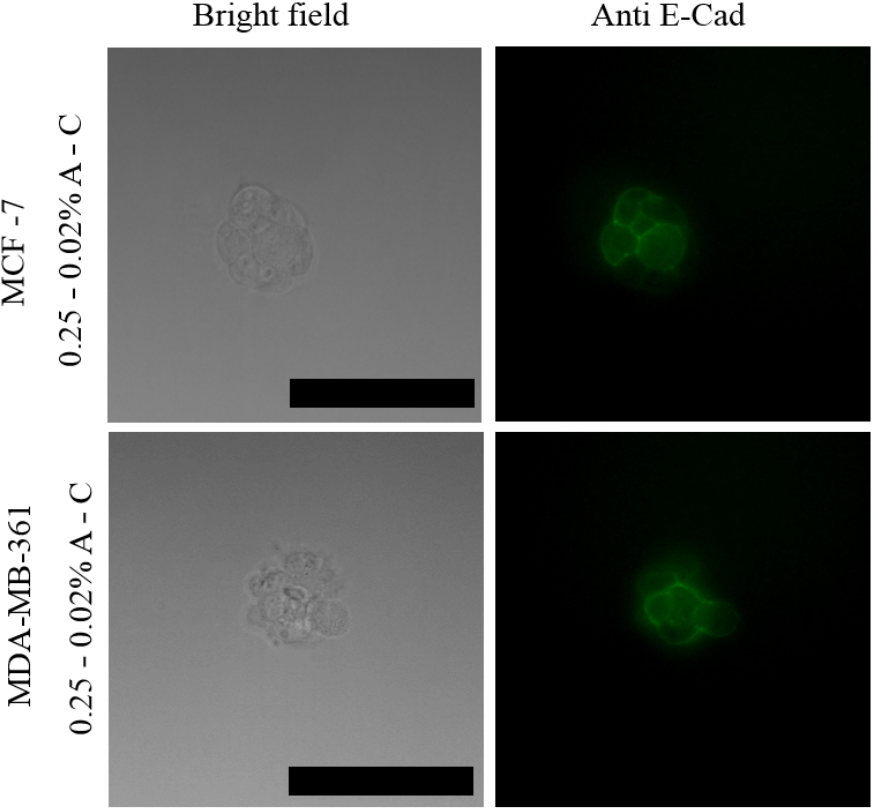
Figure 7. Staining of E-cadherin in cellular spheroids of MCF-7 and MBA-MB-361 after 5 days of growth in A-C hydrogels. Scale bars correspond to 58 µm.